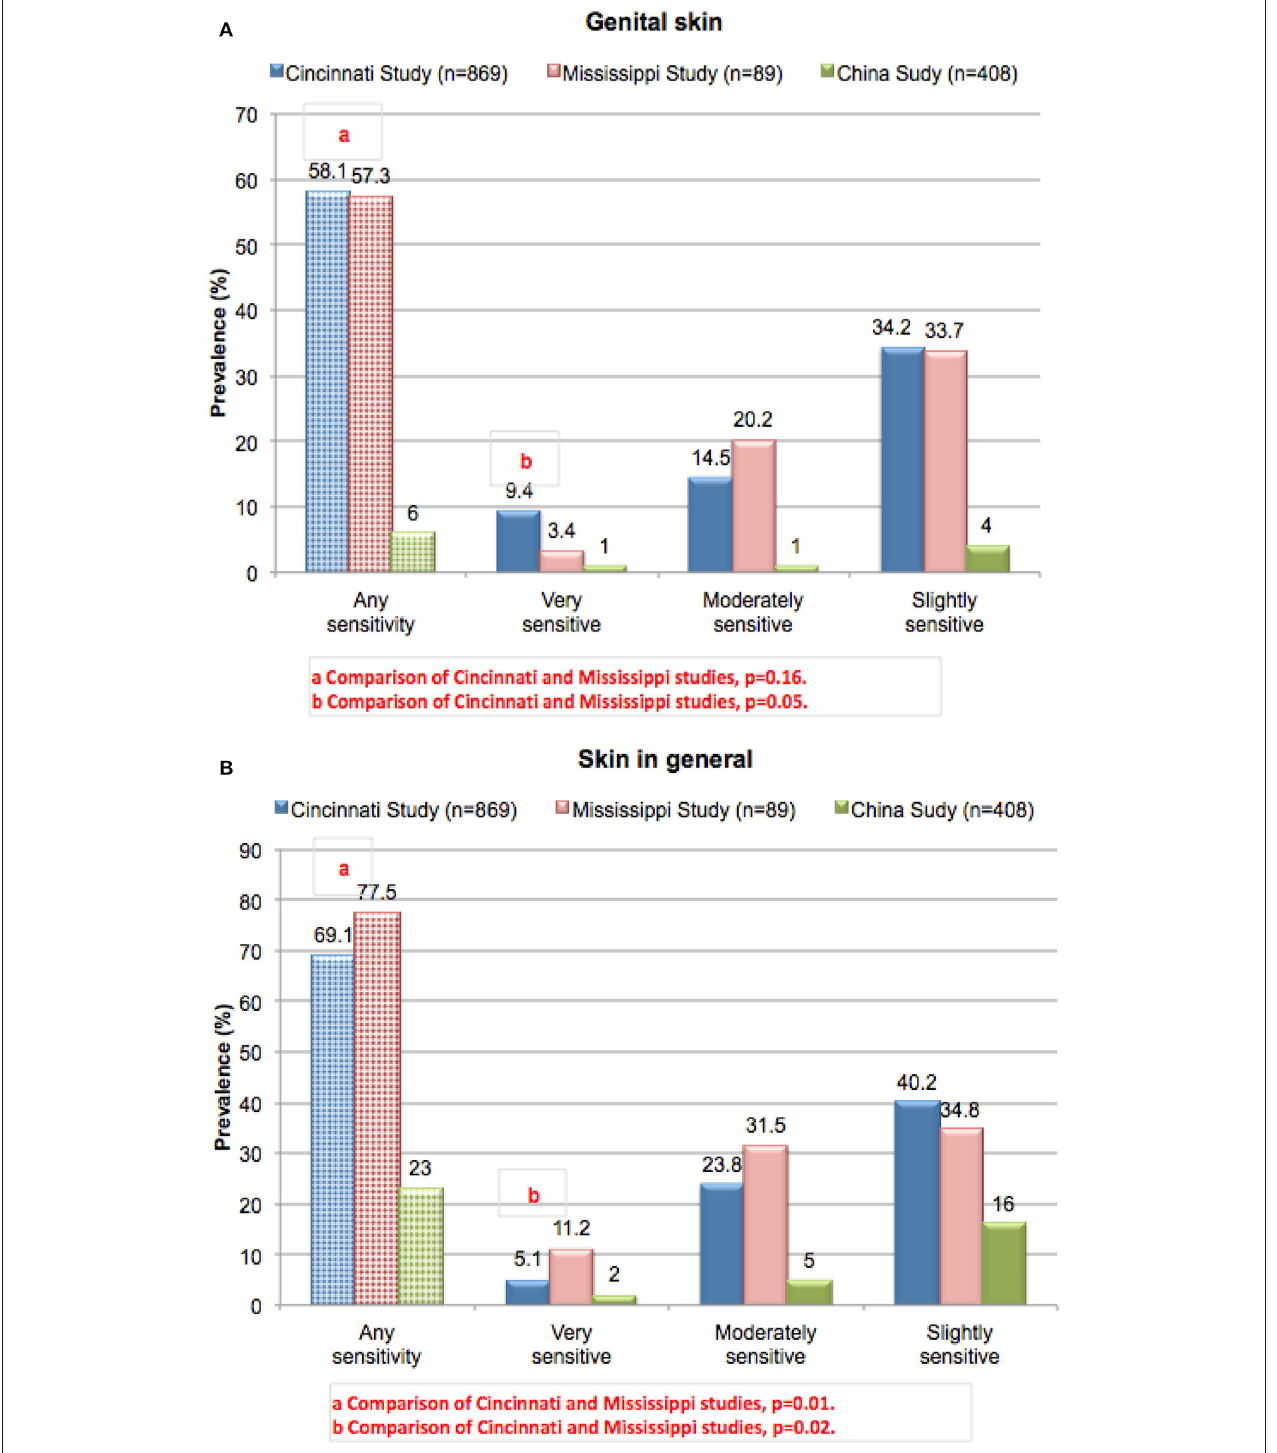
FIGURE 3 | Prevalence of perceived sensitive skin among women. Subjects in three different geographies (urban Ohio, rural Mississippi, and China) were asked to complete the sensitive skin questionnaire described for Figure 2 . Results from the Cincinnati and Mississippi studies were compared using a Chi-square analysis. (A) Sensitive genital skin, (B) sensitive skin in general. [Data adapted from Farage (16) and Farage et al. (19, 24)].